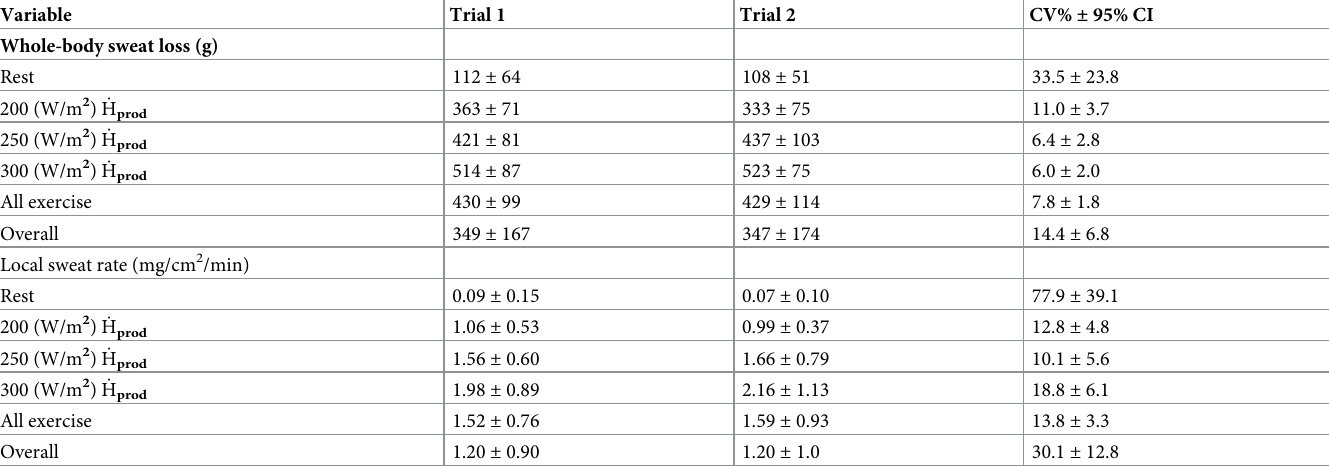
Table 1. Mean, standard deviation and reliability of whole-body sweat loss and local sweat rate at rest and a range of exercise